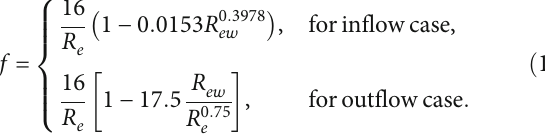
Figure 4: Flow-node unit of type